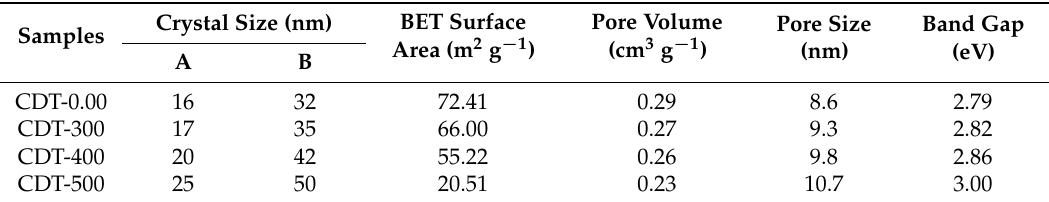
Figure 1. XRD patterns for CDT-0.00, CDT-300, CDT-400, and CDT-500 samples. Table 1. Crystal size, BET surface area, pore volume, pore size and band gap of CDT-0.00, CDT-300, CDT-400, and CDT-500